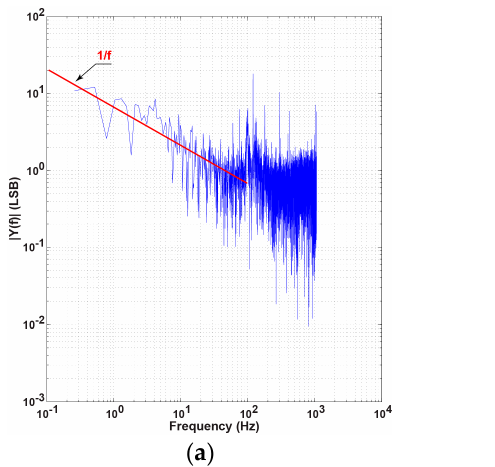
Figure 20. Benzonitrile Raman spectrum measured by coherent anti-stokes Raman spectroscopy (CARS) ( red ) and SRS ( blue ). 5. Conclusions In this paper, a high-speed lock-in pixel technology for stimulated Raman scattering CMOS imagers is presented. The proposed lock-in pixel with a high-speed demodulator using a lateral electric field control of charge and the double modulation technique for reducing residual offset and low frequency noise components successfully detects small stimulated Raman scattering signals in huge offset due to the direct pump laser light. Careful setting of the phase delay between the LEFM demodulated output signal and the readout sampling clock suppresses the residual offset and prevents the saturation of the amplifier output by the offset when a large gain of the SC integrator is used. However, we acknowledge that it is challenging to implement the phase delay across an array of pixels. The implemented lock-in pixel successfully detects a small AC signal whose AC/DC power ratio is less than 10 − 5 . The SRS spectrum of Benzonitrile has been successfully measured. These results are a significant advancement toward the goal of realizing the SRS CMOS image sensor. Acknowledgments: This research was supported by the Japan Science and Technology Agency (JST) under Collaborative Research Based on Industrial Demand “ In Vivo Molecular Imaging: Towards Biophotonics Innovations in Medicine”, and partly by the Japan Society for the Promotion of Science (JSPS) Grant-in-aid for Scientific Research (S), No. 25220905. Author Contributions: De Xing Lioe, Kamel Mars, Shoji Kawahito, Keita Yasutomi and Keiichiro Kagawa conceived and designed the image sensor. Takahiro Yamada and Mamoru Hashimoto prepared the laser setup. All authors performed the experiment. De Xing Lioe and Kamel Mars carried out the data analysis and drafted the manuscript. Shoji Kawahito and Mamoru Hashimoto provided the overall guidance to the project. All authors have read and revised the manuscript. Conflicts of Interest: The authors declare no conflict of interest.